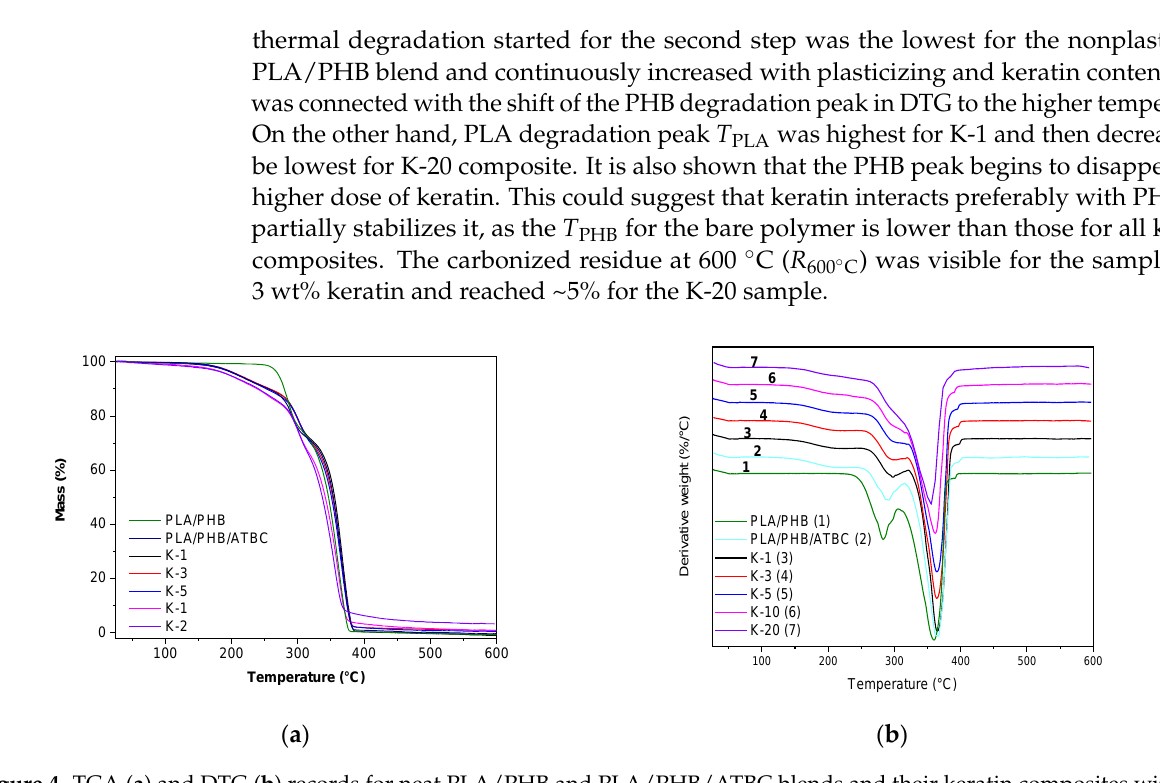
Figure 4. TGA ( a ) and DTG ( b ) records for neat PLA/PHB and PLA/PHB/ATBC blends and their keratin composites with different keratin contents varying from 1 to 20 wt%. Table 2. Parameters obtained from TGA and DTG records for neat PLA/PHB and PLA/PHB/ATBC blends and their keratin composites with different keratin contents varying from 1 to 20 wt%.